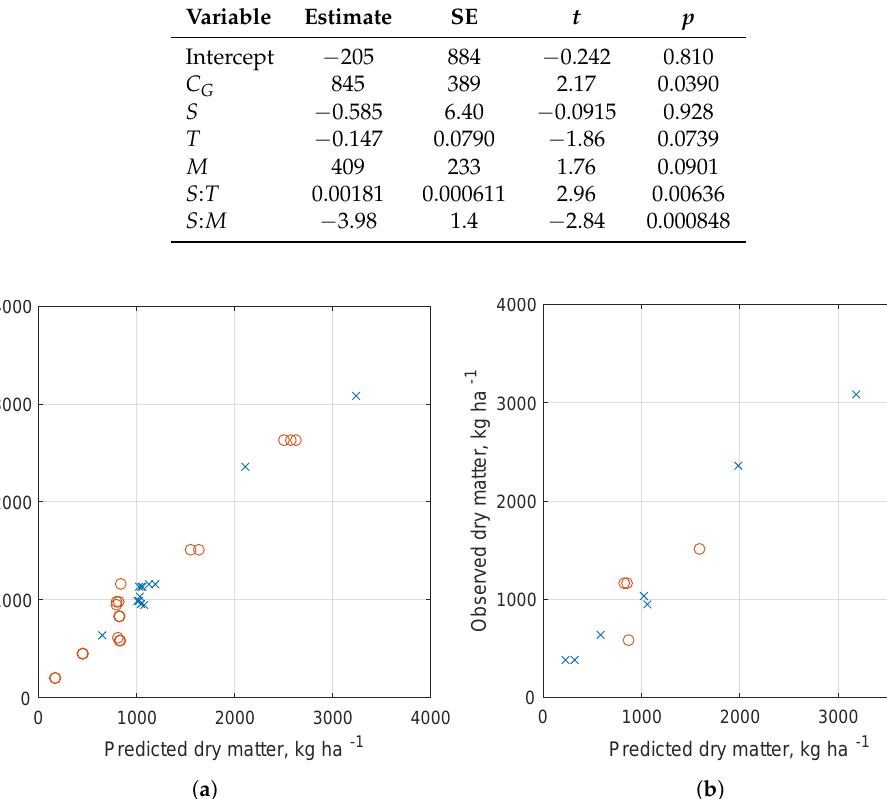
Figure 8. Correlation plots of predicted and observed total dry matter for the training set ( a ) and test set ( b ). The cross and circles indicate the two different seed mixtures used. Table 4. Error measures for the total dry matter model. The error measures are the Root Mean Square Error (RMSE), Normalized RMSE (NRMSE), the Mean Absolute Error (MAE) and the Mean Absolute Relative Error (MARE) for the training and test